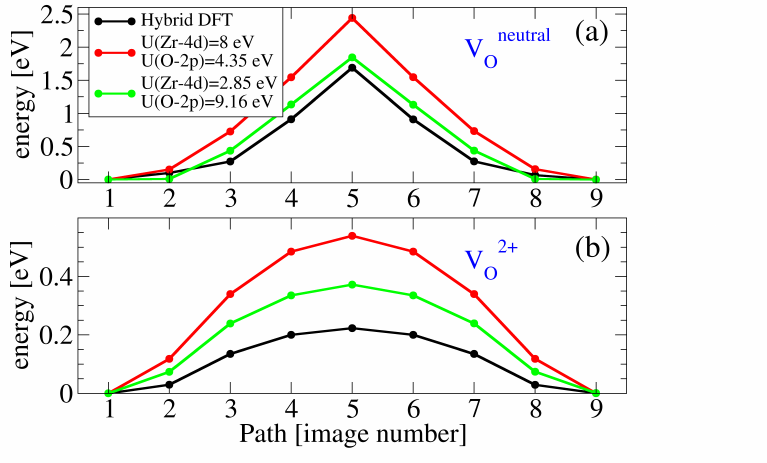
Figure 5. Nudged Elastic Band (NEB) calculation of the transition path for a vacancy migration: ( a ) for the case of V O ; ( b ) for the case of V O2+